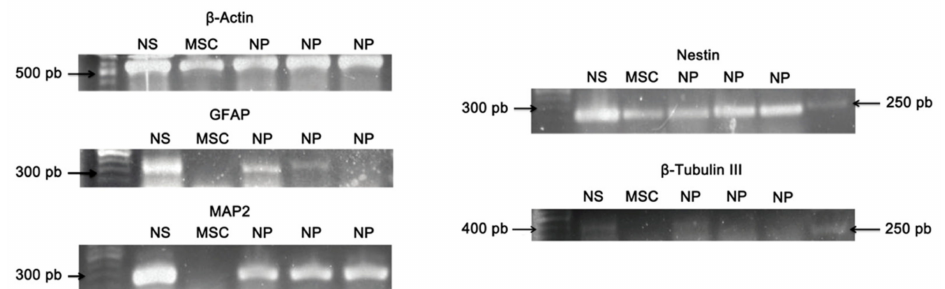
Figure 5. RT-PCR for markers of precursor neural cells. The ß-ACTIN gene was used as a technique control, and expression was observed for all samples. The GFAP gene was expressed in NS and NP samples. The MAP2 gene was expressed in NS and NP’s gene. The NESTIN gene was expressed for all samples, and the ßIII-TUBULIN was observed in NS and NP samples. Abbreviations: not dissociated neurospheres: NS; MSC-WJ: MSC; neural precursor cells: NP.